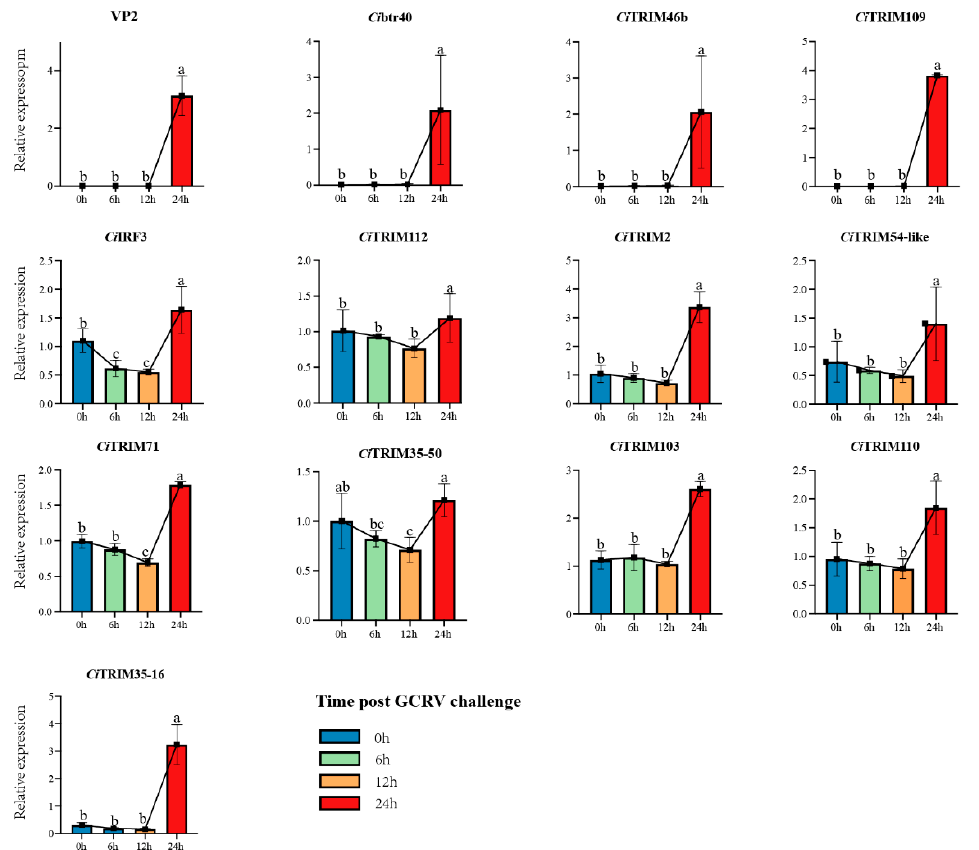
Figure 7. Expression profiles of VP2, Ci IRF3 and 11 Ci TRIMs in response to GCRV challenge in CIK. Expression data were normalized using β -actin as internal control; error bars indicate standard deviations among three biological replicates. The letters (a, b and c) indicate significant differences among expression levels at different time points after GCRV challenge ( p < 0.05).